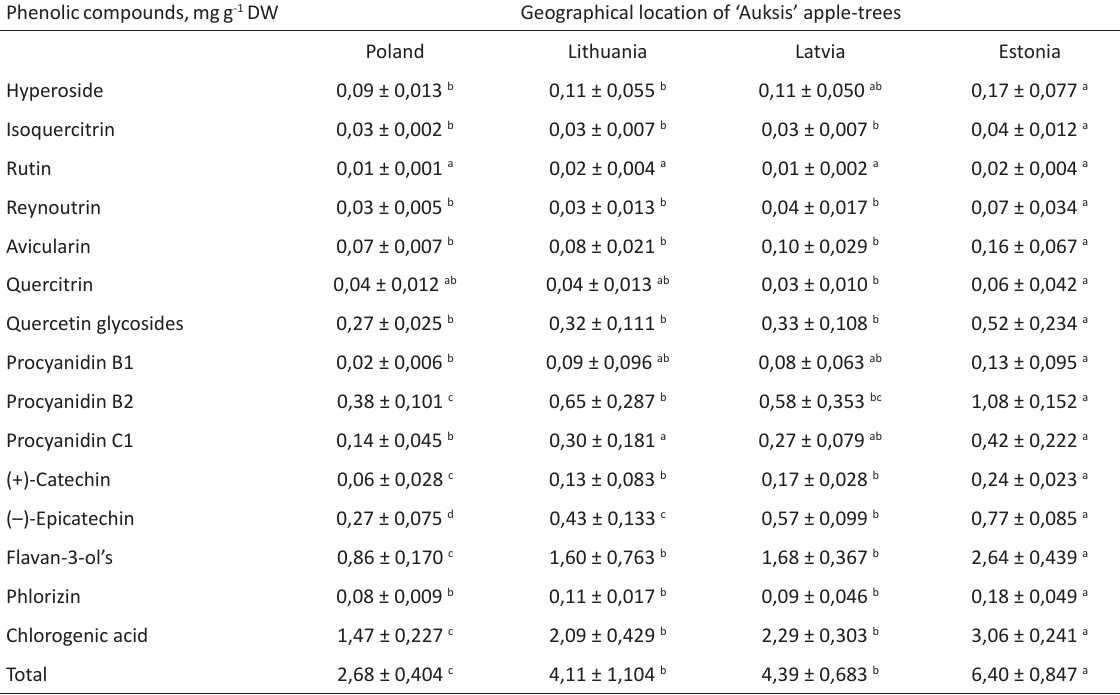
Table 1. Amount of investigated phenolic compounds (mg g -1 DW) in apples grown in different geographical locations (cv.